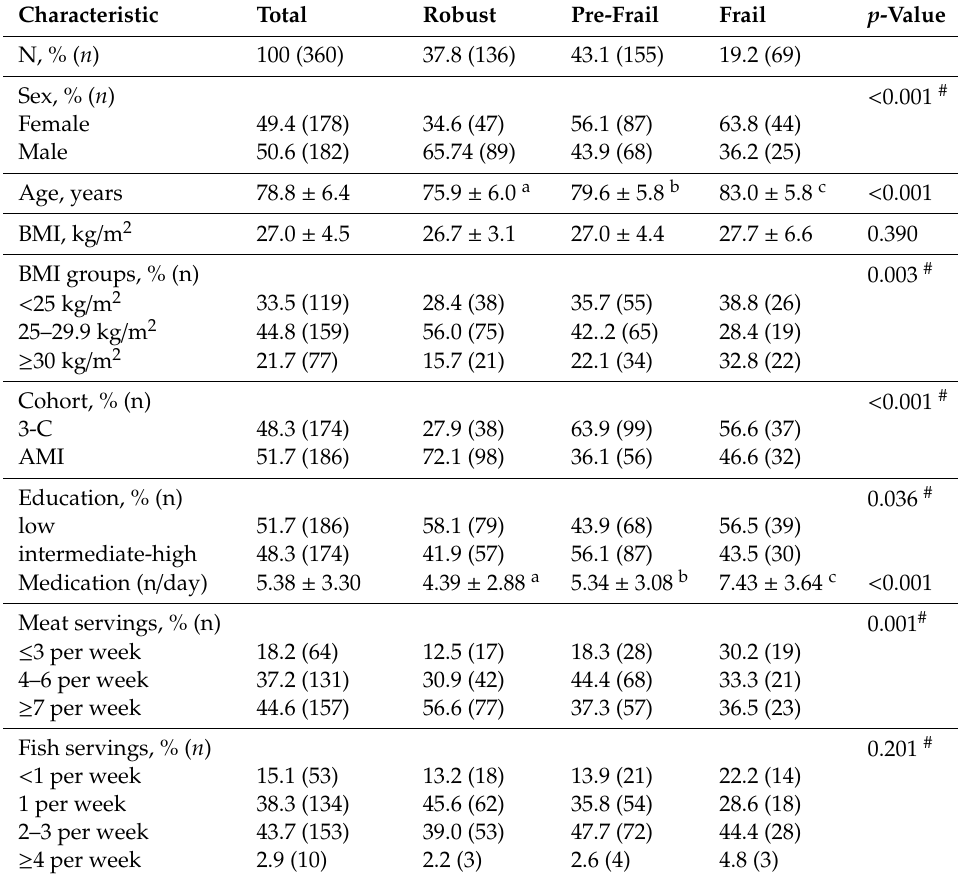
Table 1. Sociodemographic, clinical and dietary characteristics by frailty status among 360 participants from the 3-City Bordeaux and AMI cohorts involved in the FRAILOMIC initiative.